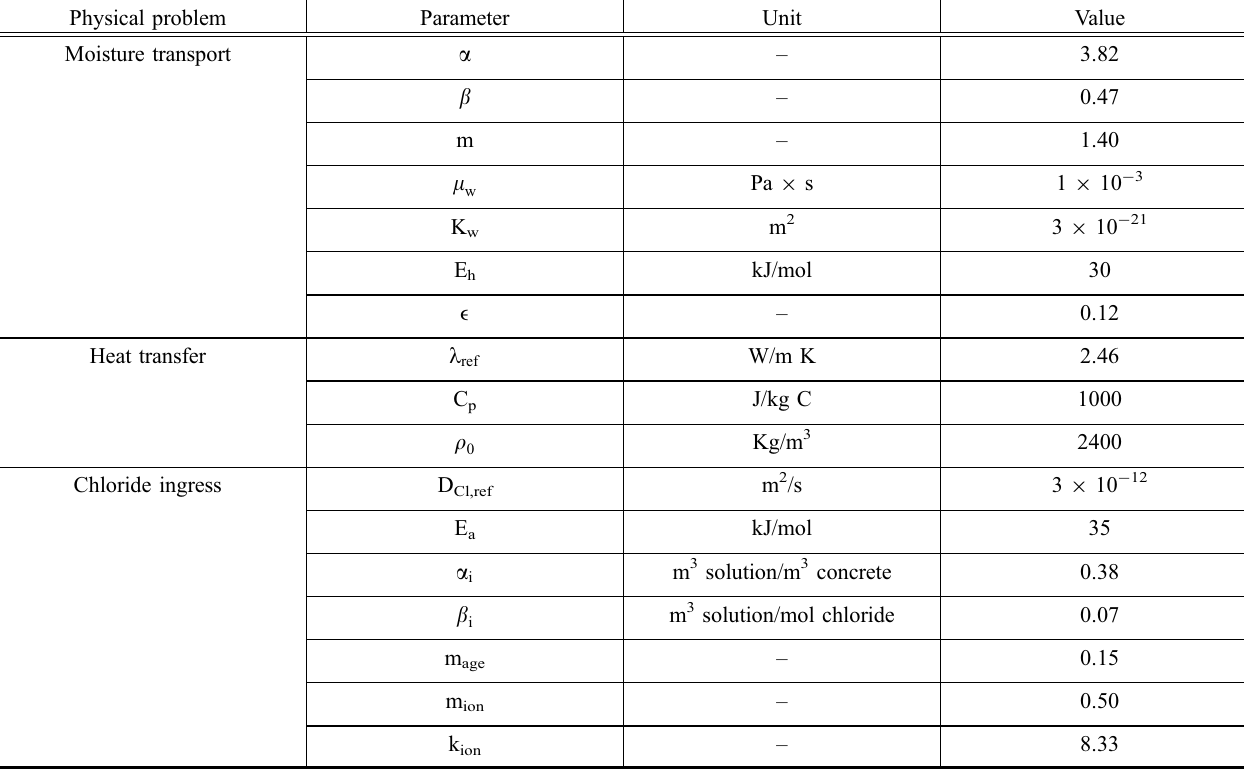
Table 2 Material parameters (Samson and Marchand 2007; Nguyen